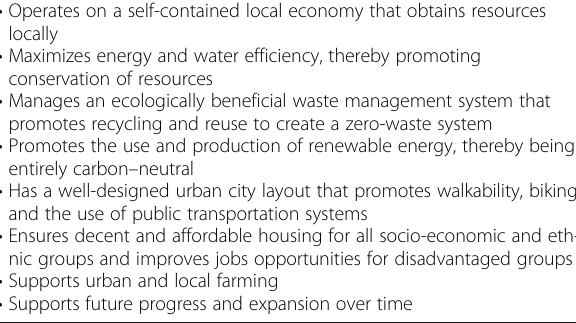
Table 4 Criteria of an ideal